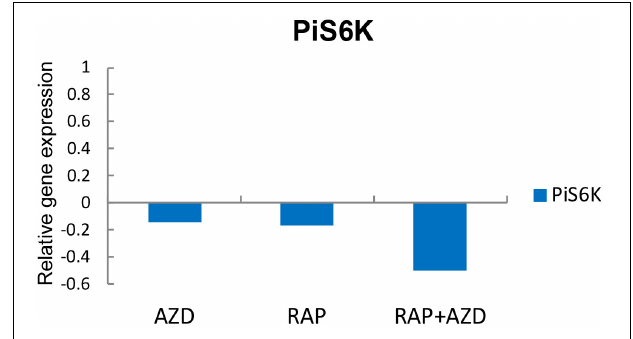
FIGURE 8 | Gene expression of PiS6K in RAP, AZD and RAP +